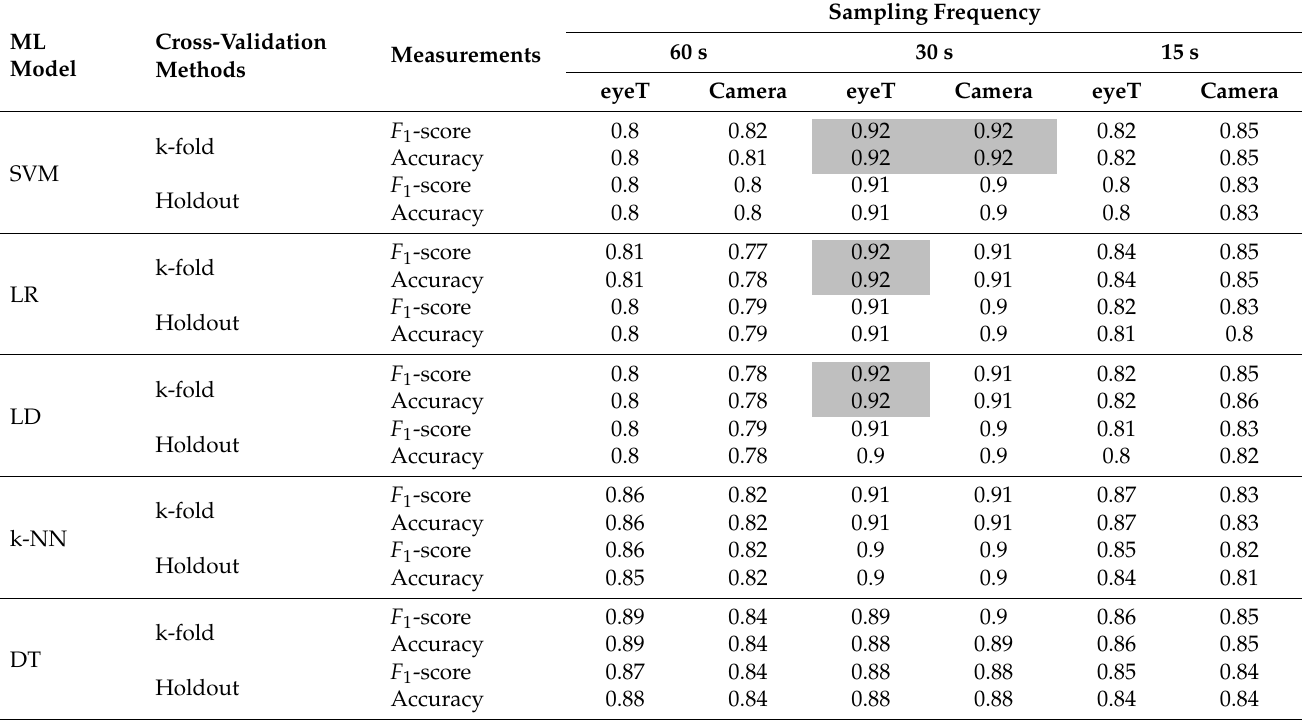
Table 4. Summary of the comparison of different sampling frequencies.